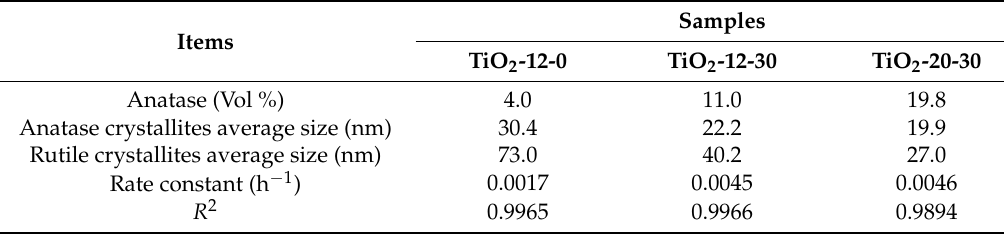
Figure 2. XRD patterns of TiO 2 coatings: ( a ) TiO 2 ‐ 12 ‐ 0, ( b ) TiO 2 ‐ 12 ‐ 30, and ( c ) TiO 2 ‐ 20 ‐ 30. Table 2. Phase compositions and crystallites size of TiO 2 coatings.